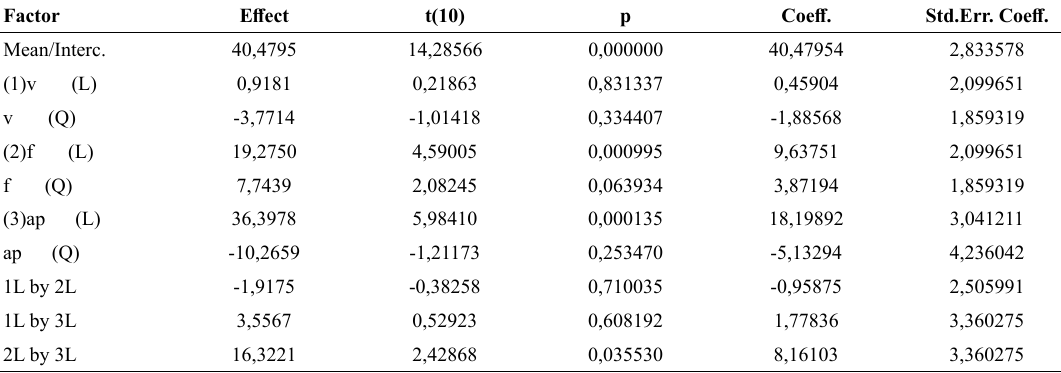
Table 5. ANOVA for the effect of the independent variables on feed rate force. Factor Effect t(10) p Coeff. Std.Err. Coeff.